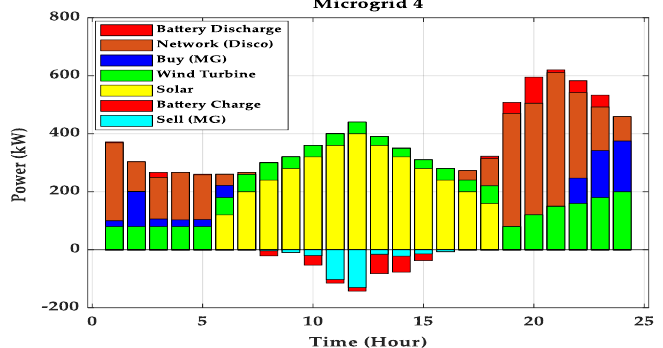
Figure 11. Microgrid 4 ’s load and generation curve.